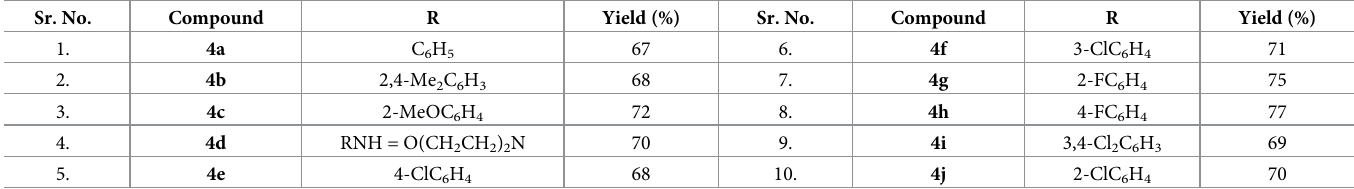
Table 1. Synthesized N -4-piperazinyl ciprofloxacin derivatives 4a-j [17]. Sr.